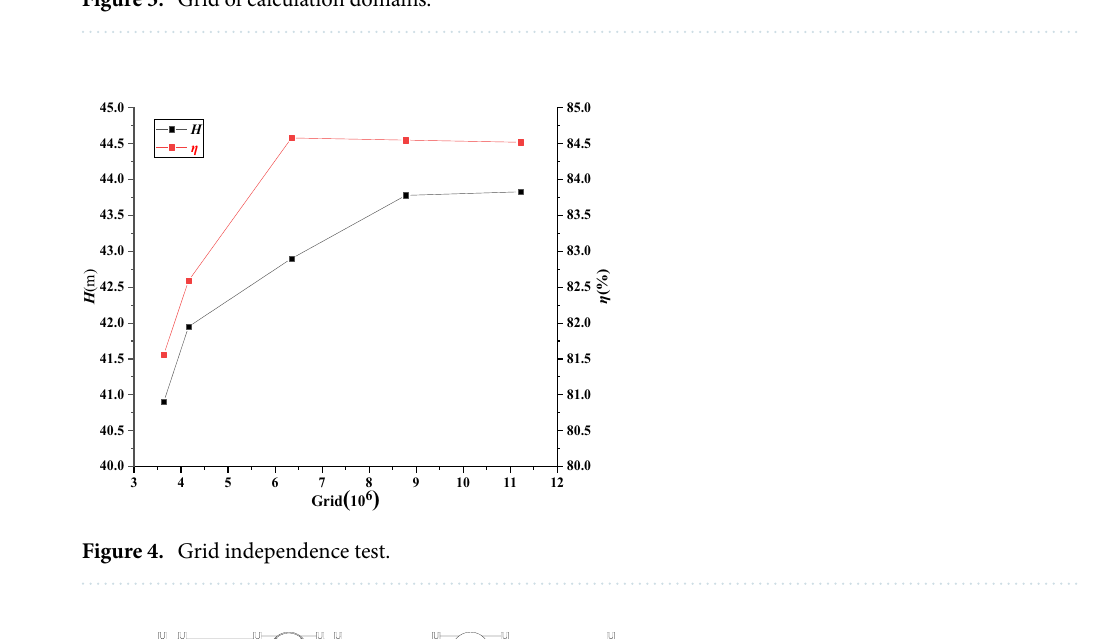
Figure 3. Grid of calculation domains.